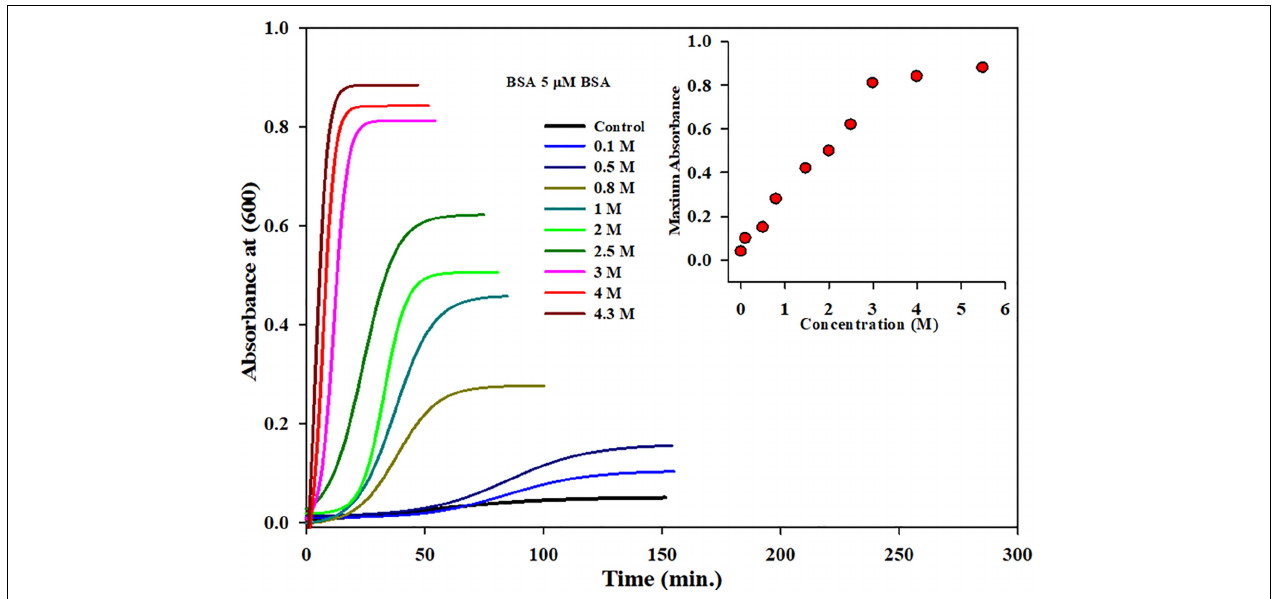
FIGURE 2 | Kinetic measurements of BSA in presence increasing concentrations of monosodium glutamate (0.1 to 4.5 Molar) at 70 ◦ C temperature, 25 mM phosphate buffer, pH. 7.0 and 600 nm. Inset of Figure 2 inset shows the influence of concentration on ( A max ) maximum absorbance of MSG-induced BSA aggregation at 70 ◦ C